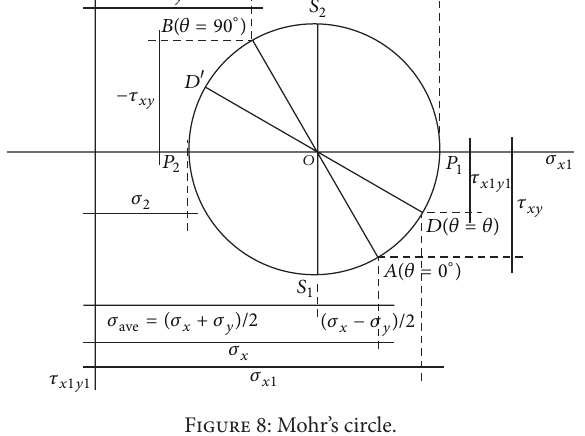
Figure 8: Mohr’s circle.